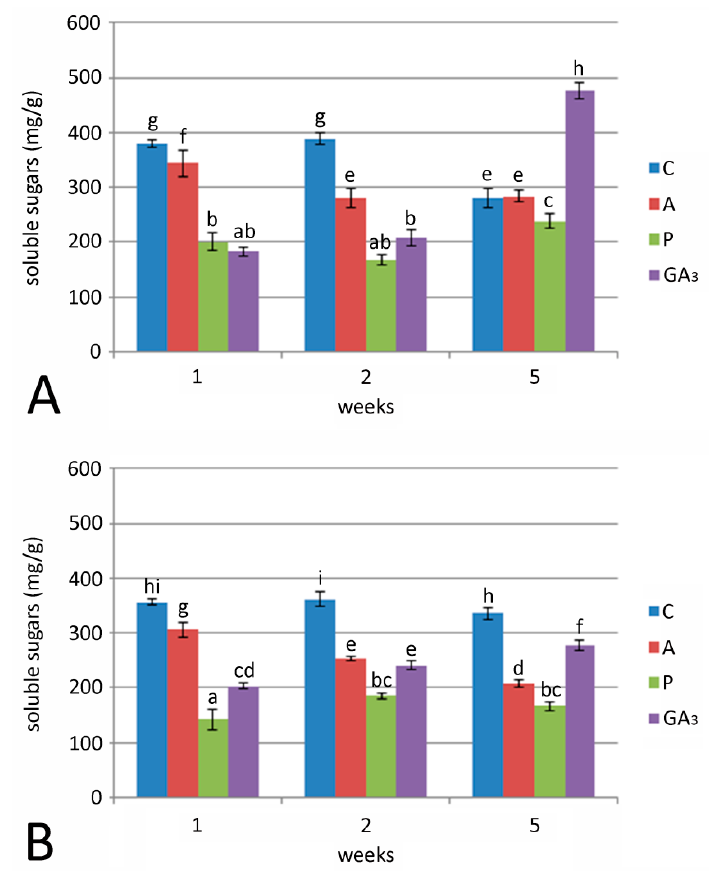
Figure 3. Effect of GA 3 and GA inhibitors: ancymidol (A) and paclobutrazol (P) on soluble sugar concentration in F. meleagris bulbs cultured for 1, 2 and 5 weeks at 24 °C ( A ) and 7 °C ( B ). C—bulbs cultured on medium without PGR; different letters indicate significant differences between treatments at p < 0.05 (LSD test).